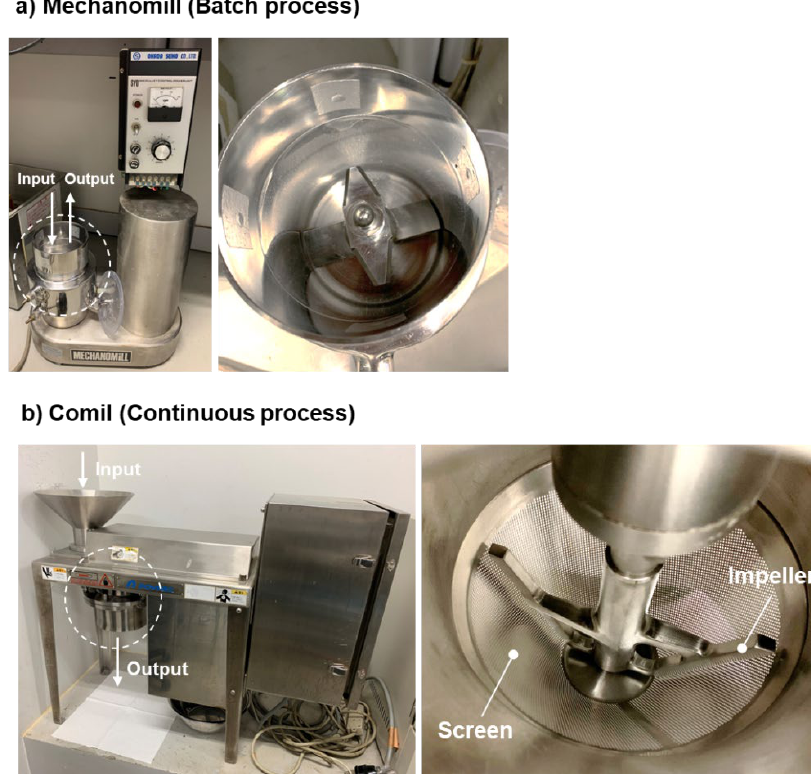
Figure 1. Images of ( a ) Mechanomill and ( b ) Comil equipment used for the dry coating of silica nanoparticles on active pharmaceutical ingredients. In each panel, the white circle in the left image delineates the powder-processing area of each machine (right photograph).